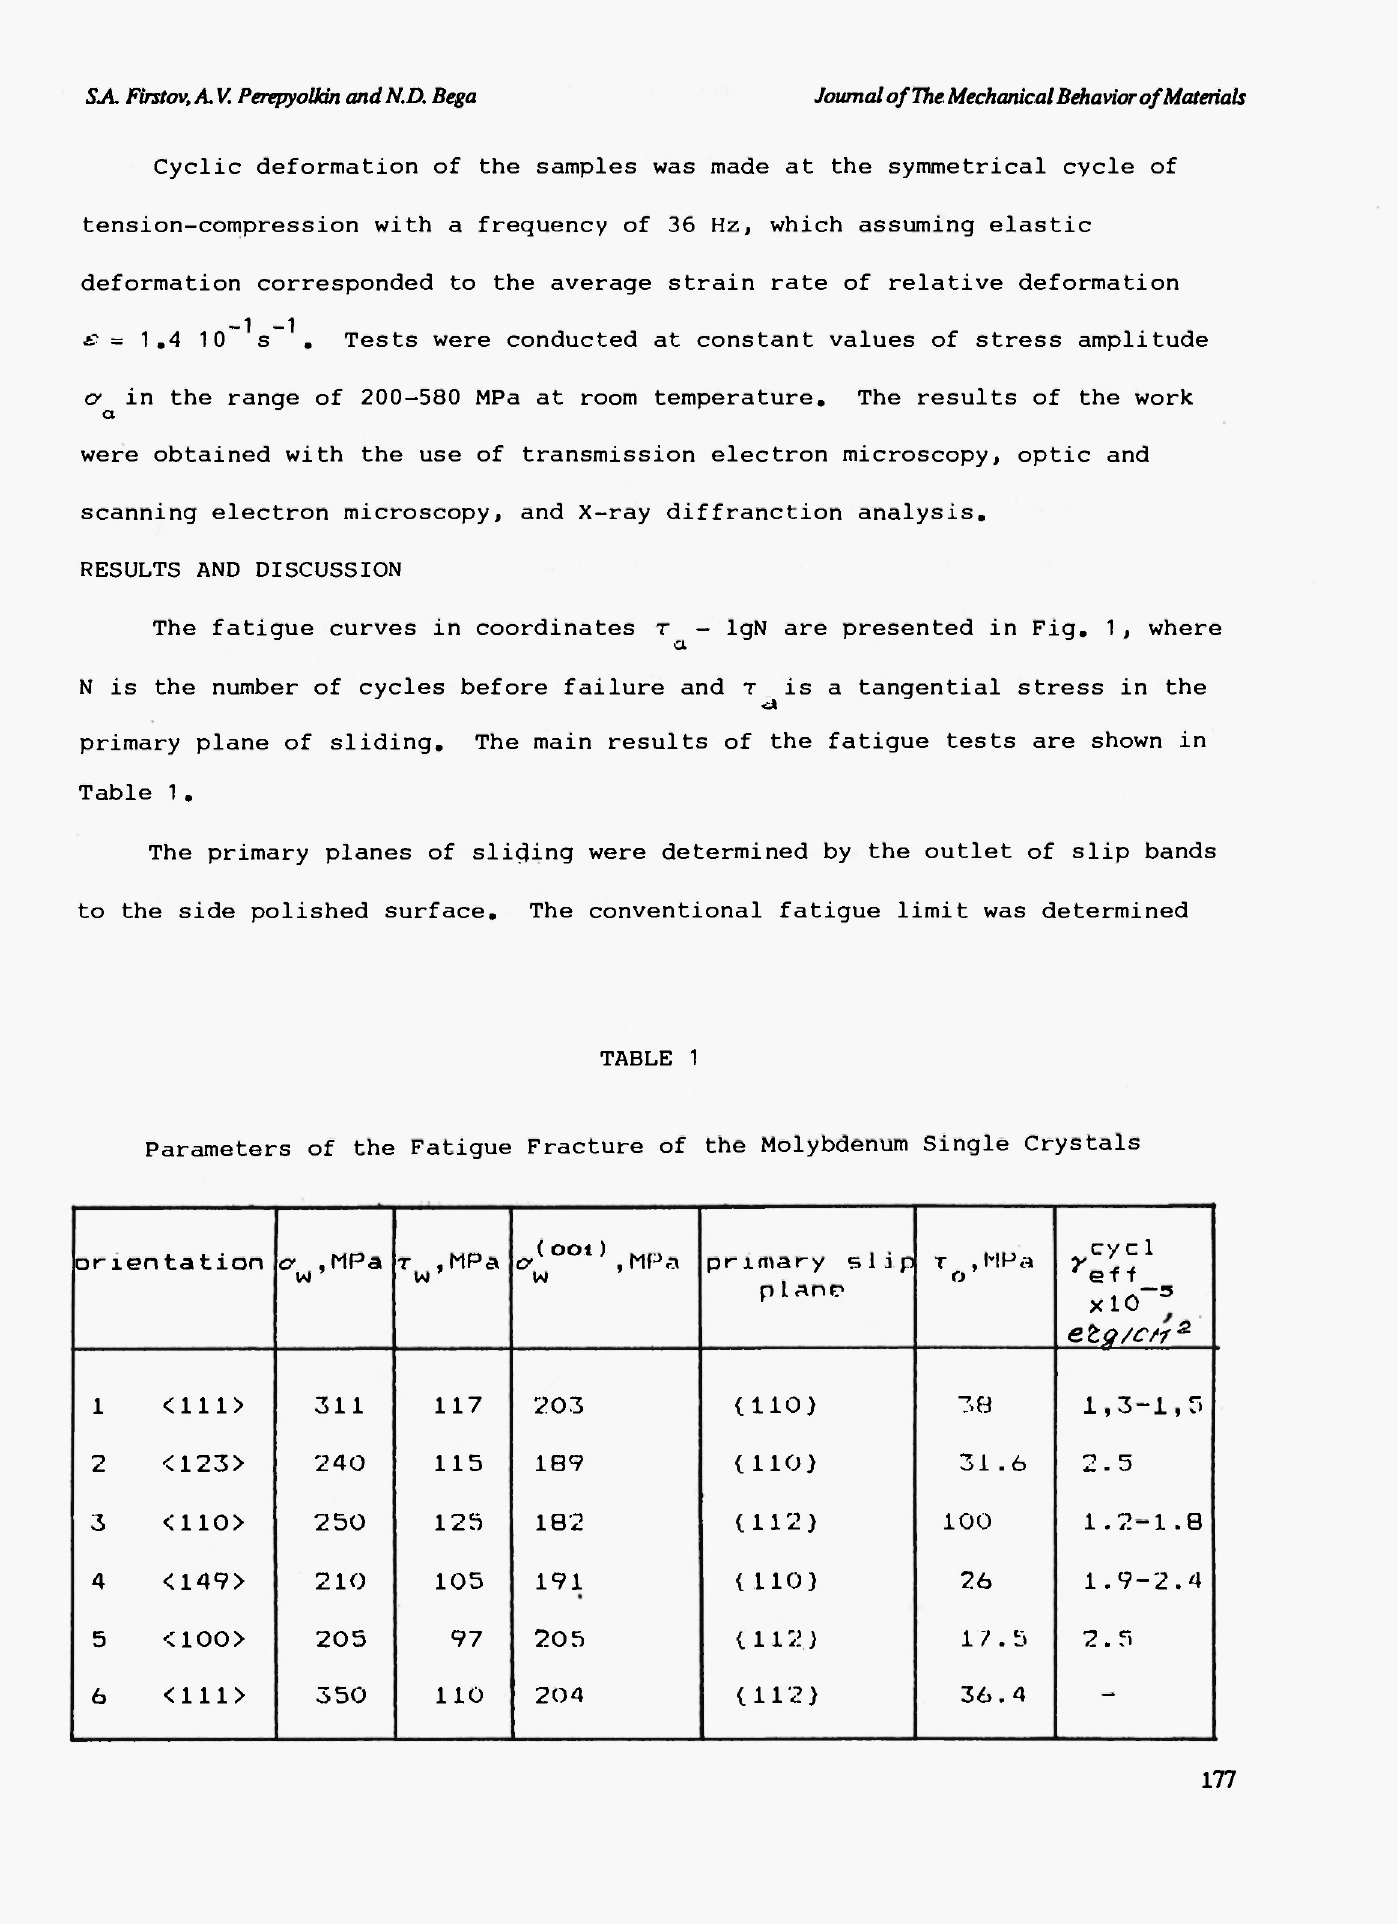
The primary planes of sliding were determined by the outlet of slip bands to the side polished surface.